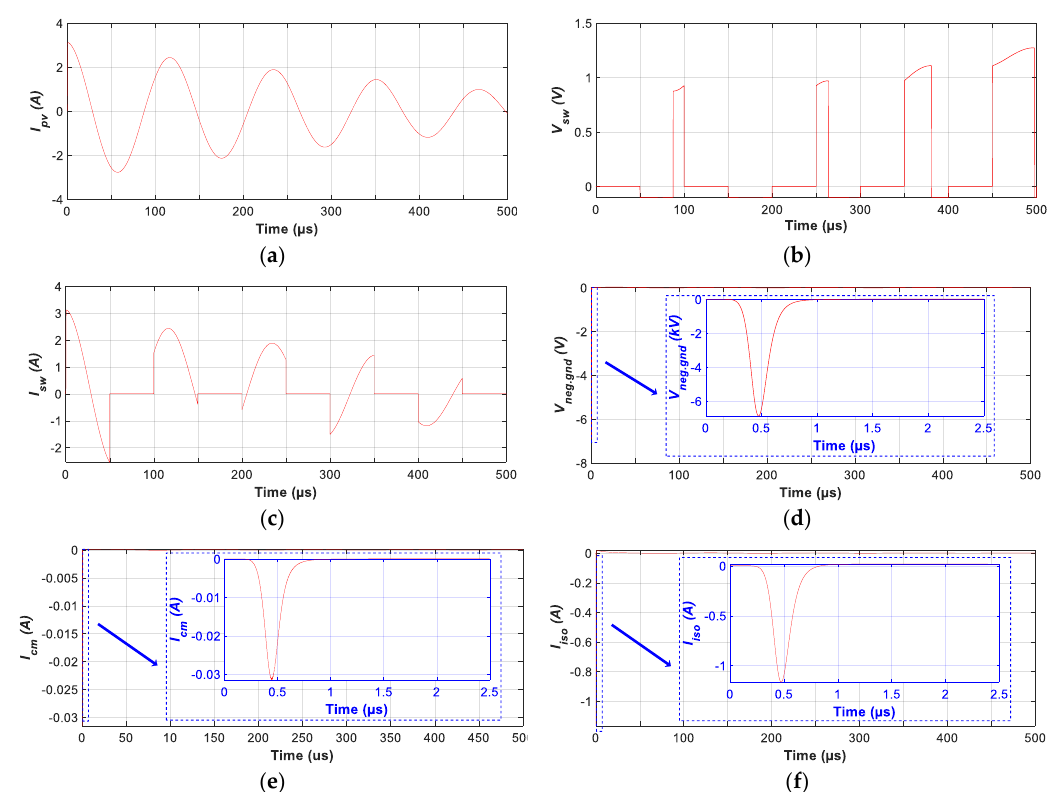
Figure 13. Case of subsequent short stroke, induced voltages at the PV module. Vertical strike hitting 5 m away from the module.